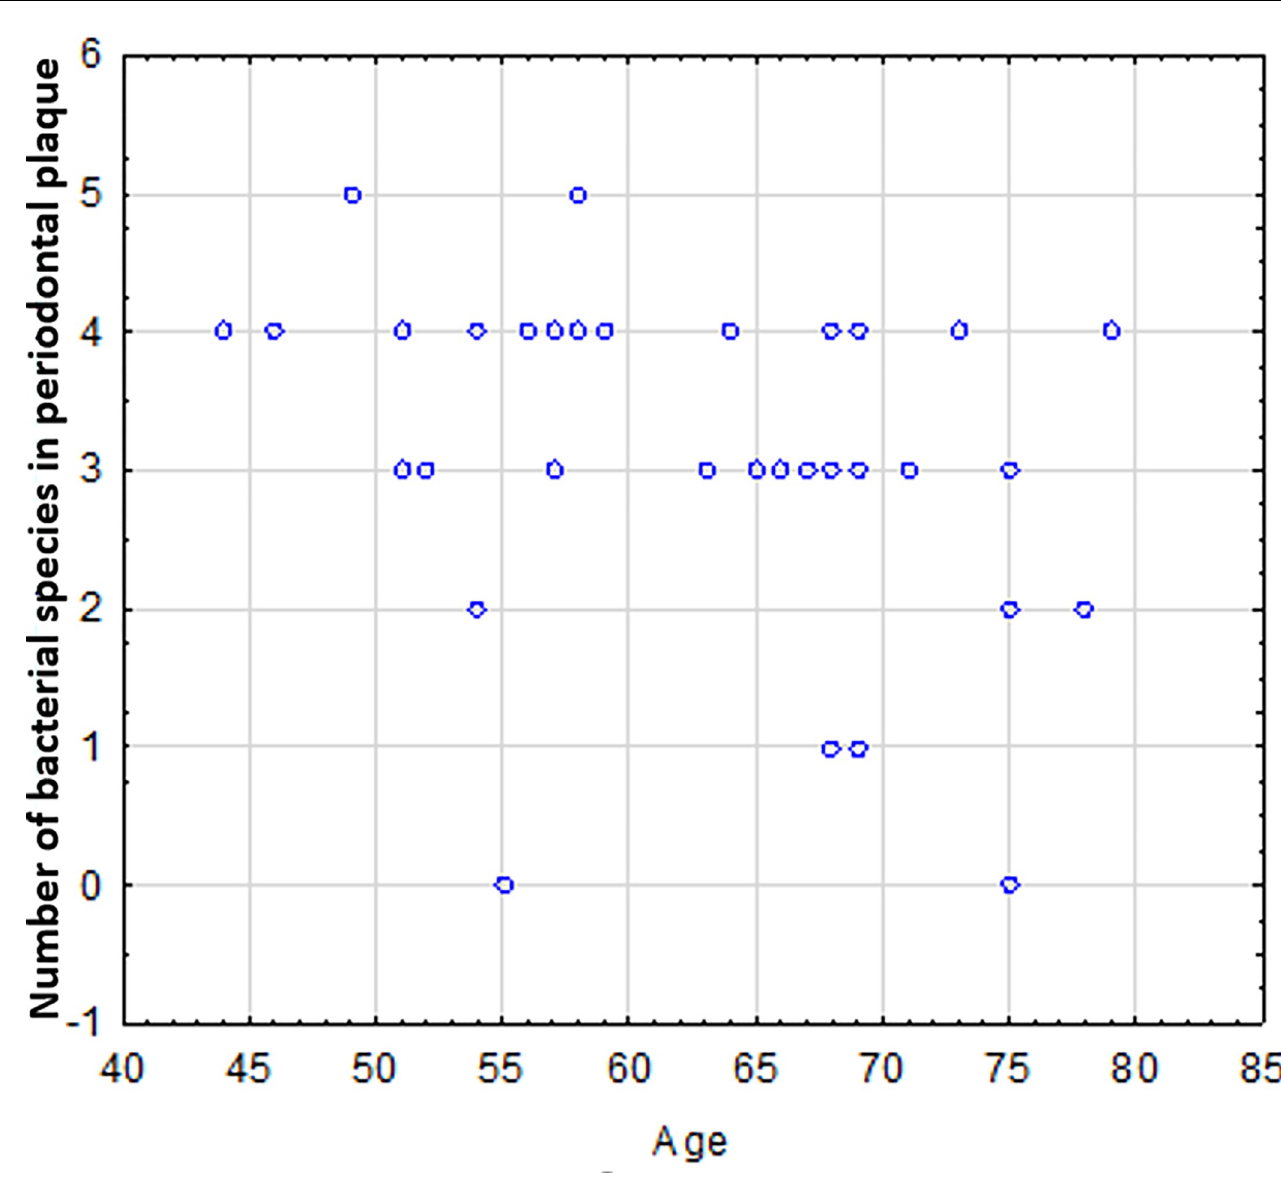
Fig 5. The prevalence of 5 bacterial species in subgingival plaque